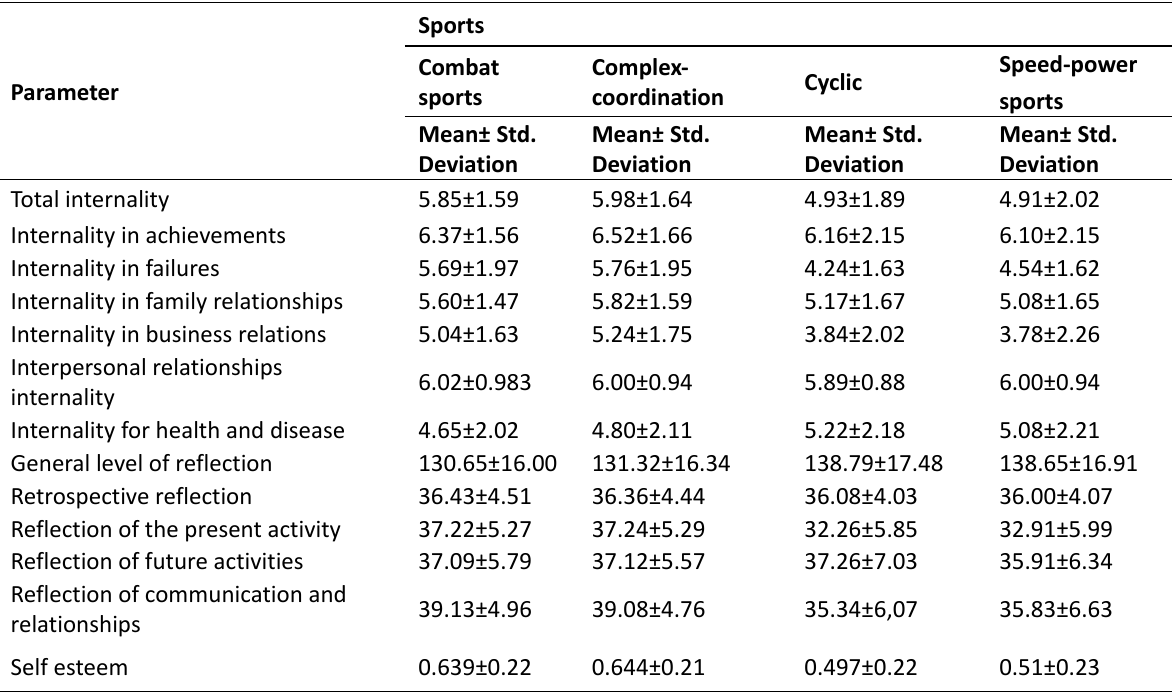
Table 4. Features of the manifestation of personal qualities of athletes of different sports